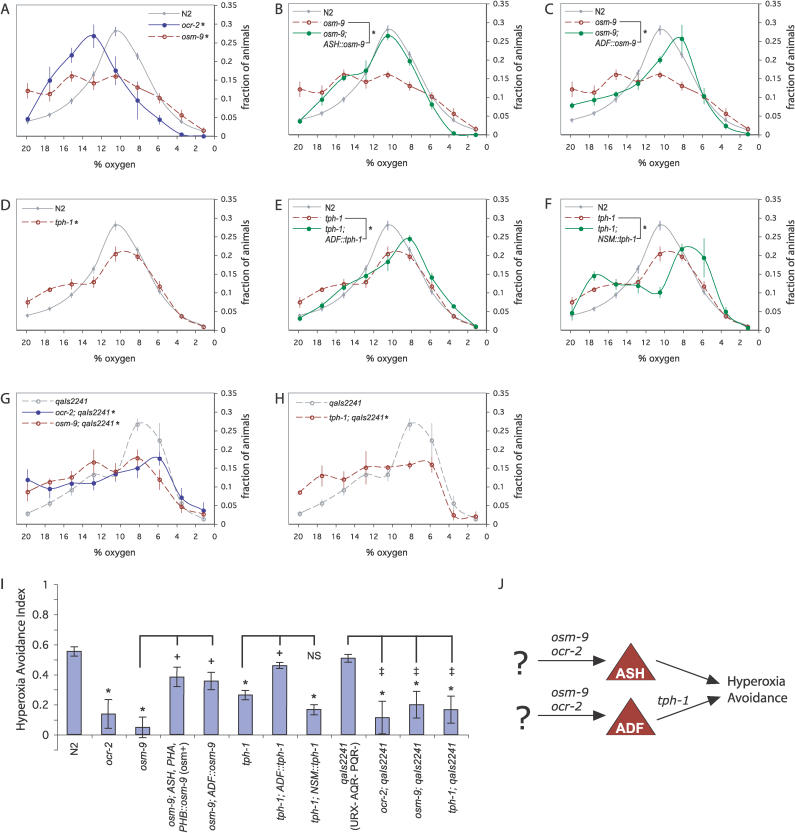
Multiple TRPV-Expressing Neurons Contribute to Hyperoxia Avoidance(A) Aerotaxis of TRPV single mutants. The median preferred oxygen concentration of ocr-2 mutants was significantly higher than N2 (p < 0.05 by Dunnett test).(B) Aerotaxis of osm-9 mutants in which ASH, PHA, and PHB were rescued with an osm-10::osm-9 transgene [26]. Animals rescued for ASH function were preselected for avoidance of high osmolarity, an ASH behavior (see Materials and Methods).(C) Aerotaxis of osm-9 mutants in which ADF was rescued by expression from a cat-1::osm-9 transgene [26].(D) Aerotaxis of tph-1 mutants.(E) Aerotaxis of tph-1 mutants rescued in ADF neurons using a srh-142::tph-1::gfp transgene [28].(F) Aerotaxis of tph-1 mutants rescued in NSM neurons using a ceh-2::tph-1::gfp transgene [28].(G) Aerotaxis of TRPV; qaIs2241 double mutants.(H) Aerotaxis of tph-1; qaIs2241 double mutants.For (A–H), asterisks denote distributions different by chi-square analysis at p < 0.01 from the first distribution in the panel, unless otherwise noted. n ≥ 3 assays per genotype, 80–100 animals/assay. Error bars denote SEM.(I) Hyperoxia avoidance index as defined in Figure 1. Asterisks, values different from N2 controls at p < 0.01 by Dunnett test. Single crosses, values different from the osm-9 or tph-1 control at p < 0.05 by Bonferroni t test with N2 and mutant controls. Double crosses, values different from qaIs2241 controls at p < 0.01 by Dunnett test. NS, not significant. Error bars denote SEM.(J) ASH and ADF sensory neurons promote hyperoxia avoidance through the activity of TRPV channels osm-9 and ocr-2. Serotonin production in ADF by tph-1, which is regulated by TRPV channels, also drives this behavior.